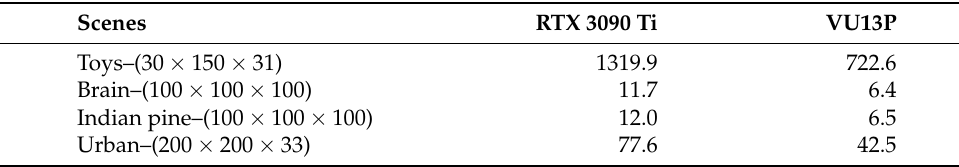
Table 7. Final reconstruction rates in